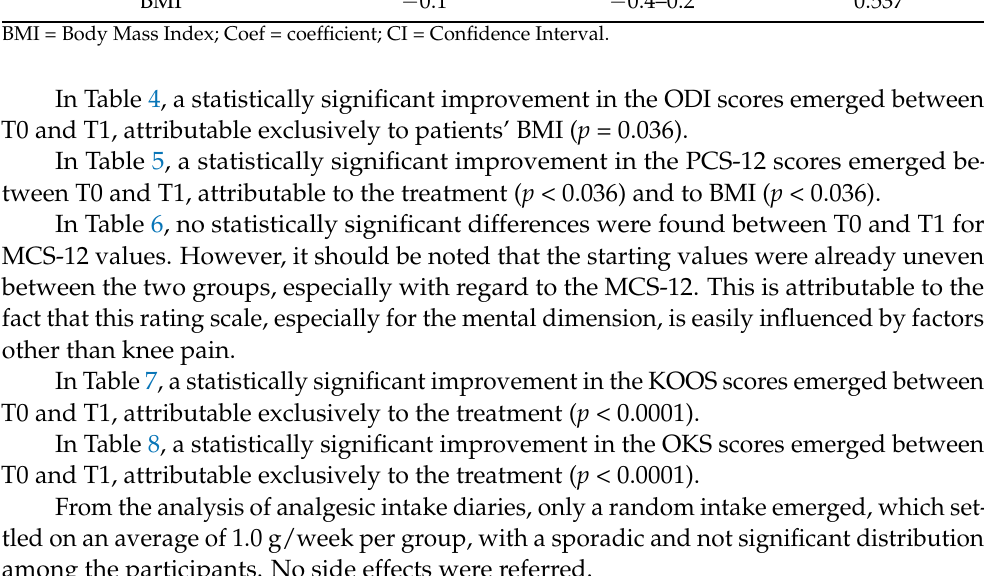
Table 8. Analysis of the determinants of the difference between OKS T1 and OKS T0 in a multivariate linear regression model. Determinants Coef. 95%CI p -Value Group (treatment vs. control) 8.5 5.4–11.7 <0.0001 Sex (male vs. female) 0.4 − 2.5–3.3 0.796 Age (years) 0.1 − 0.2–0.3 0.511 BMI − 0.1 − 0.4–0.2